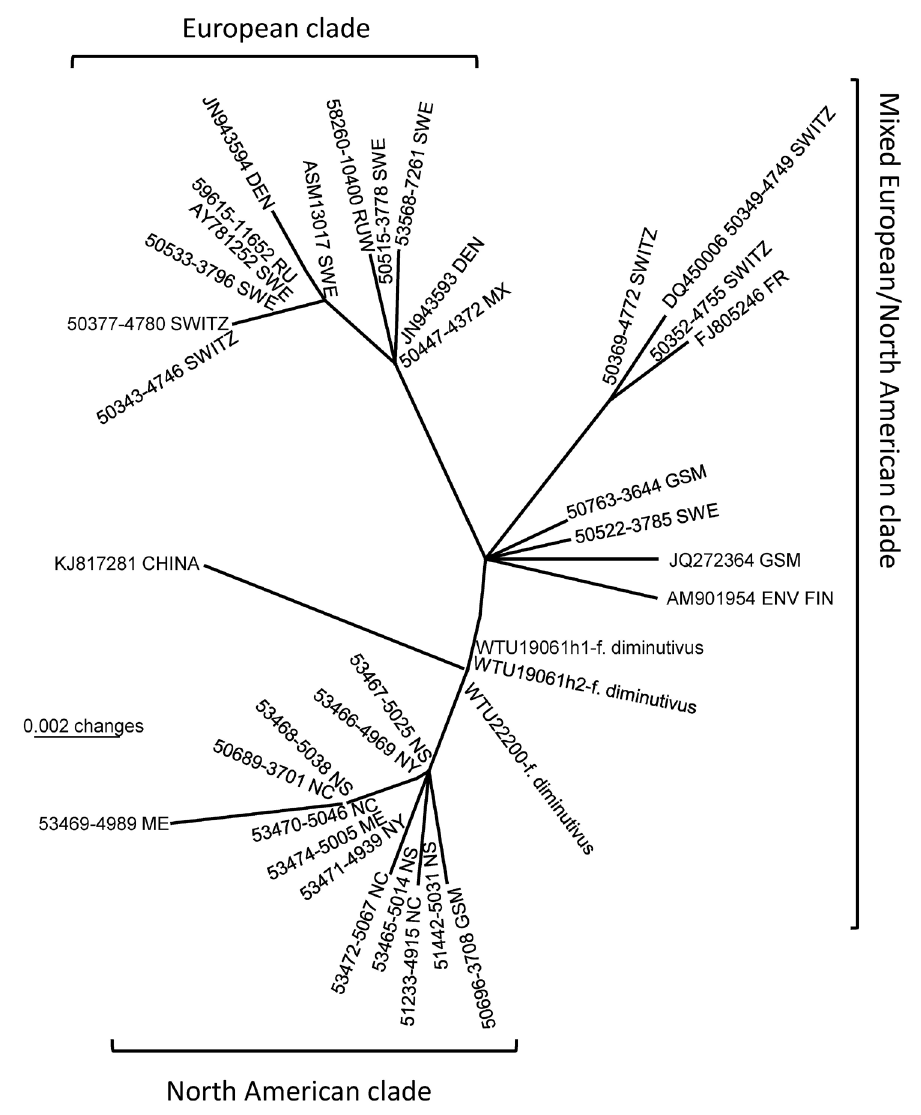
Figure 77. Mycetinis scorodonius . Unrooted PhyML of My. scorodonius collections based on the ribosomal ITS